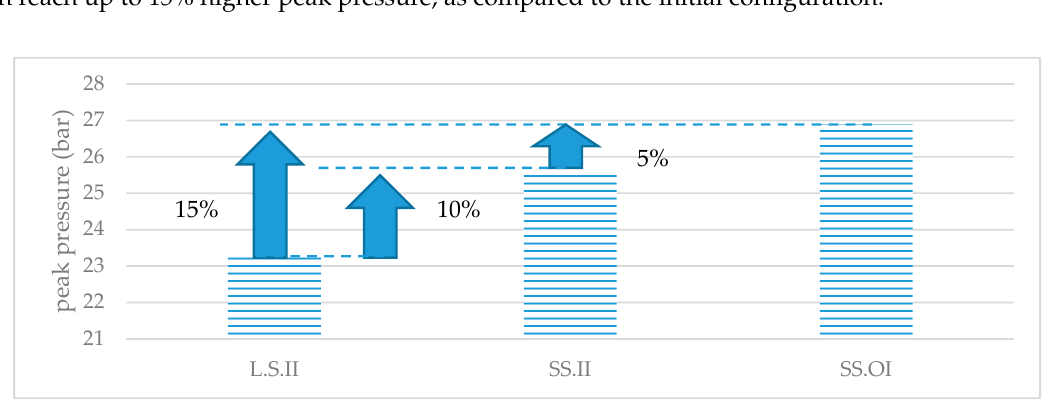
Table 2. Optimization of intake port and sealing system.